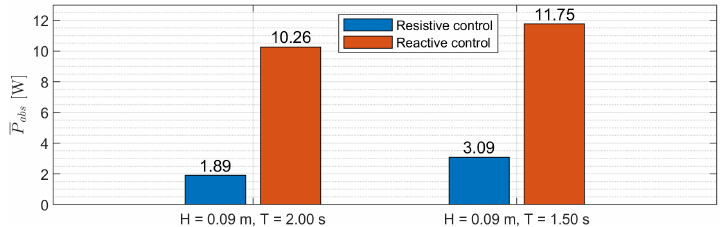
Figure 21. P abs for Test_100, Test_103, Test_138 and